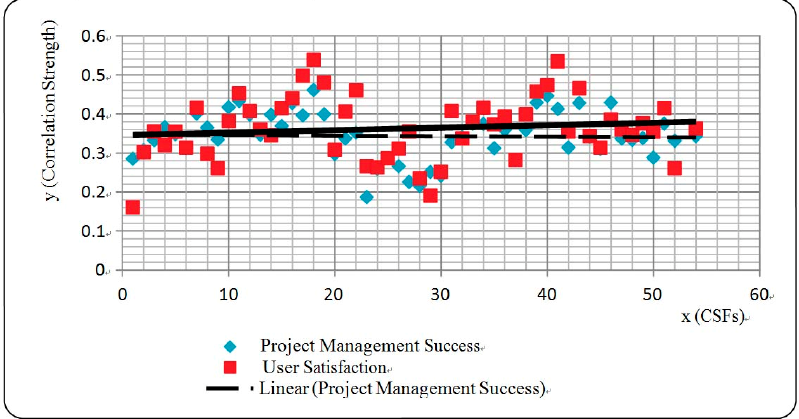
Figure 2. Scatter plot of correlation and linearity.